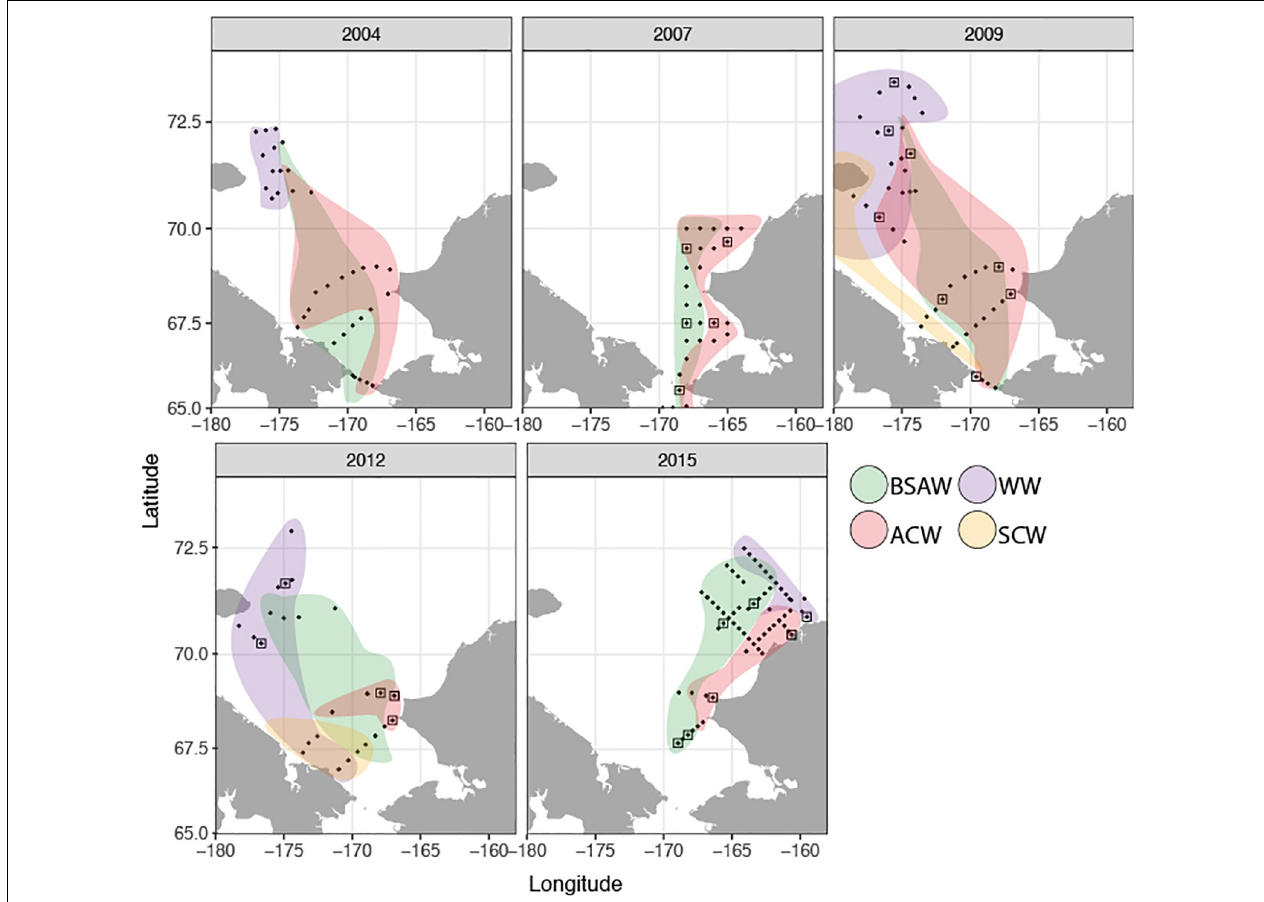
FIGURE 2 | Spatial distribution of sampled stations and schematic distribution of water masses during each sampling period [figure for 2004–2012 modified from Eisner et al. (2013), Ershova et al. (2015a,b), Pisareva et al. (2015a)]. Squares indicate stations where DNA barcoding of larvae was done. BSAW, Bering Sea Anadyr Water; ACW, Alaska Coastal Water; WW, Winter Water; SCW, Siberian Coastal